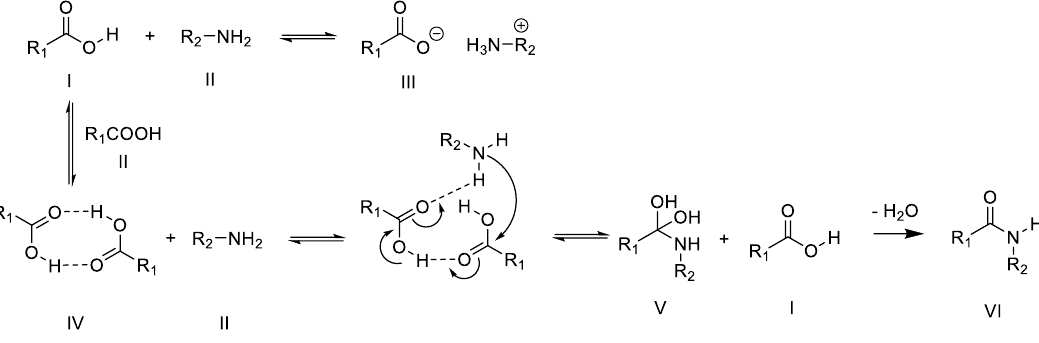
Figure 2. Size exclusion chromatography (SEC) curves of native NaCMC ( ) and NaCMC recovered after being left in contact with 13.5 eq. of benzylamine, for 4 h at 140 °C ( ).